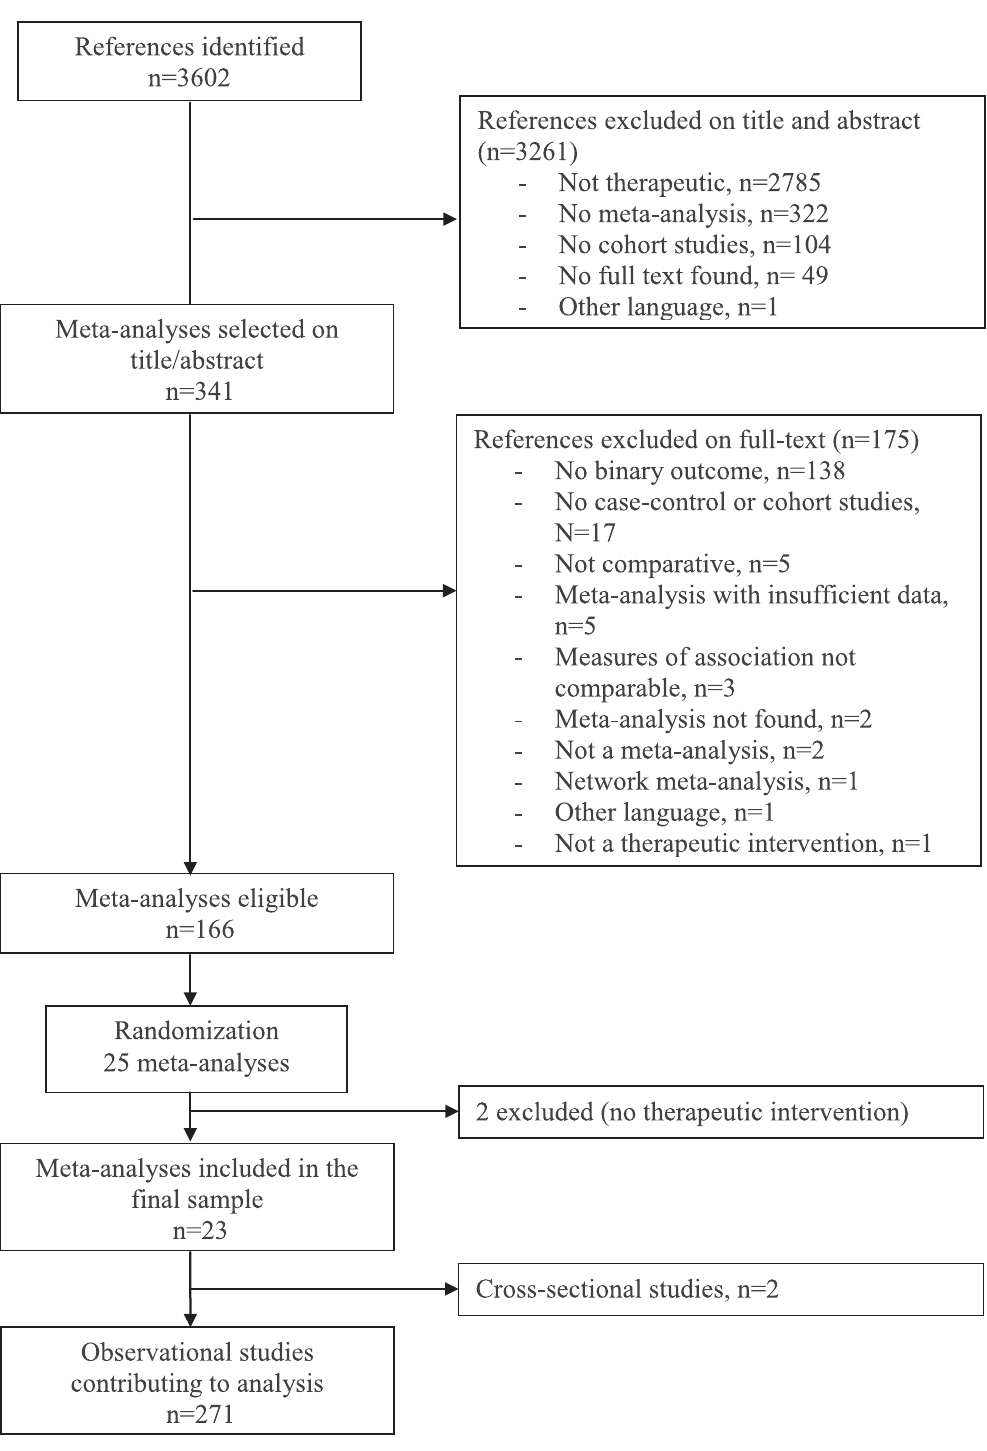
PLOS ONE | DOI:10.1371/journal.pone.0154877 May 9,